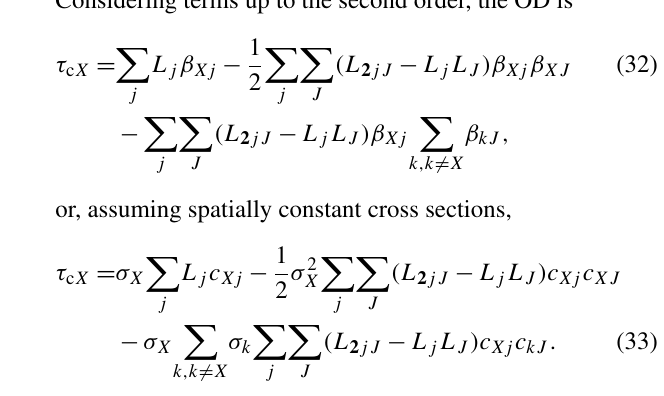
Figure 4. Difference between the sum of the ODs of the consid- ered absorbers, each calculated by the classical formula, and the OD calculated for the whole absorption (red crosses), in compari- son with the sum of the inter-correlative terms (blue line: sum of second-order terms only; green line: sum of second- and third-order terms). Top panel: the result in the UV for the limb observation scenario with TH = 19.83km and absorption scenario containing ozone, NO 2 and BrO. Bottom panel: same but in visible range and for two absorbers, ozone and NO 2